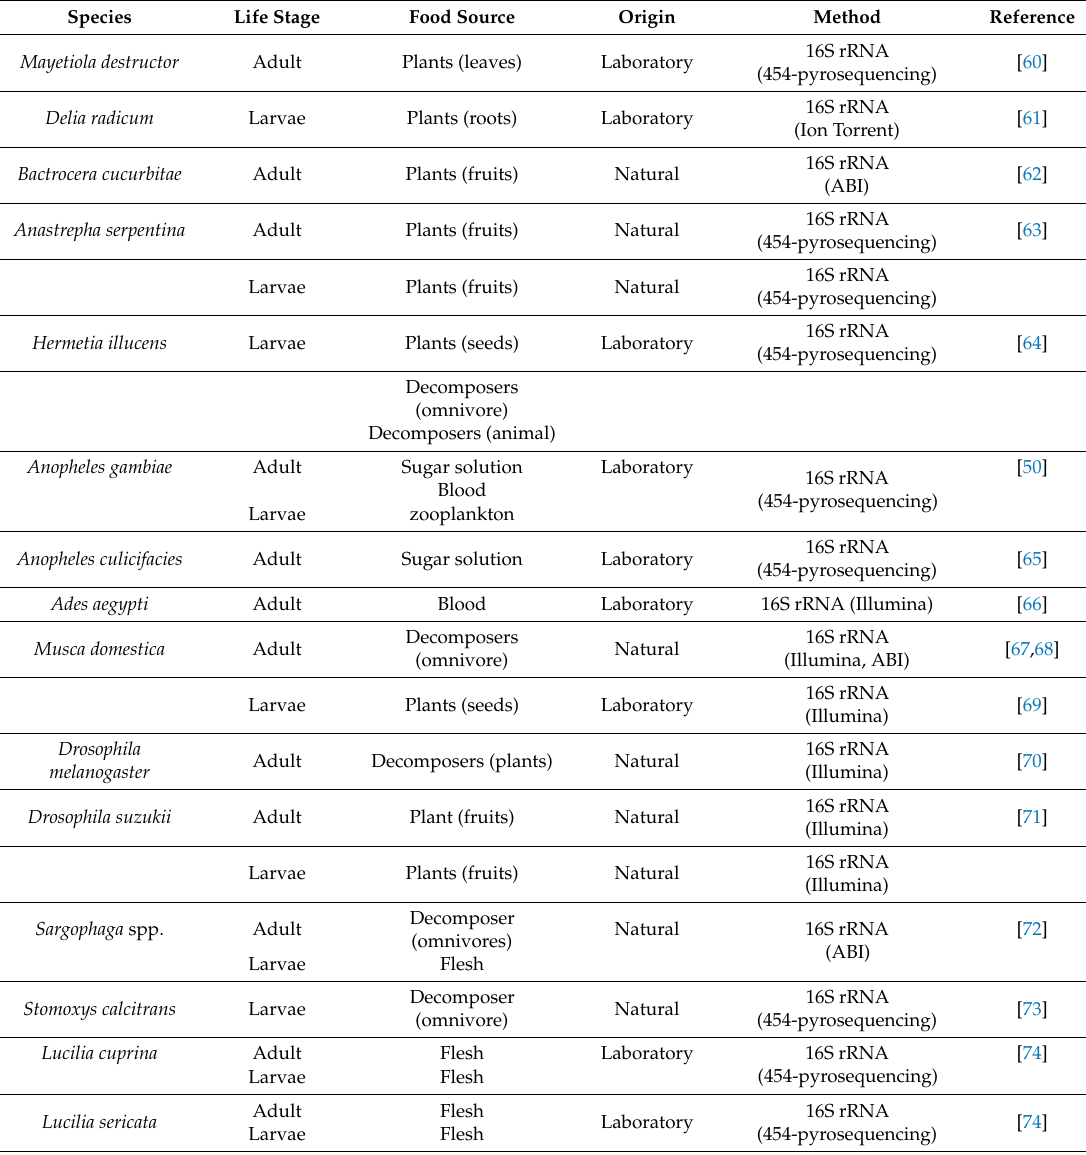
Table 1. Food sources in Diptera. Overview of food sources in di ff erent dipteran species, life stages, and corresponding studies, which were used for detecting diet-specific patterns in dipteran gut microbial